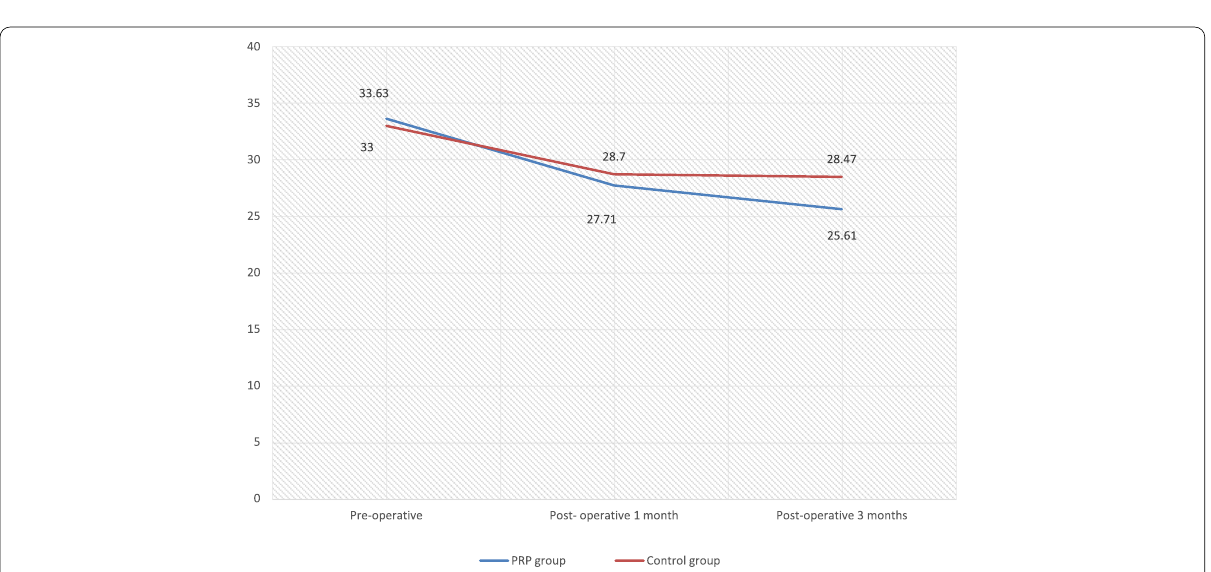
Fig. 8 Graphical representation of PTA in the pre-operative and post-operative periods in both